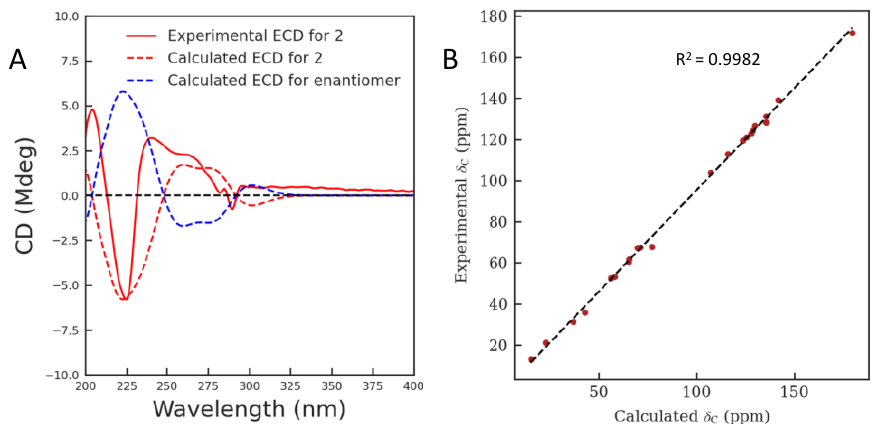
Figure 5. Quantum chemical calculations of compound 2 . ( A ) Calculated and experimental ECD spectra of compound 2 ; ( B ) Regression analysis of experimental versus calculated 13 C NMR chemical shifts of compound 2 .